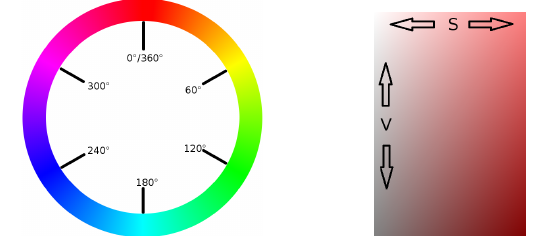
Figure 3: H channel as circle and S-V plane with sample color red H = 0